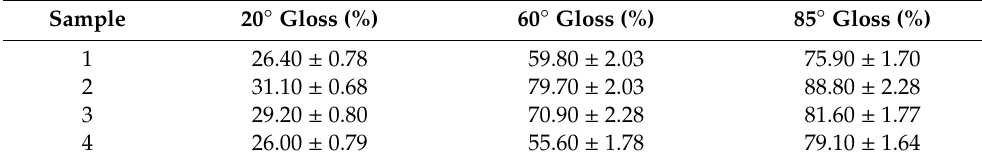
Table 5. The gloss change of waterborne coating on Chinese fir.